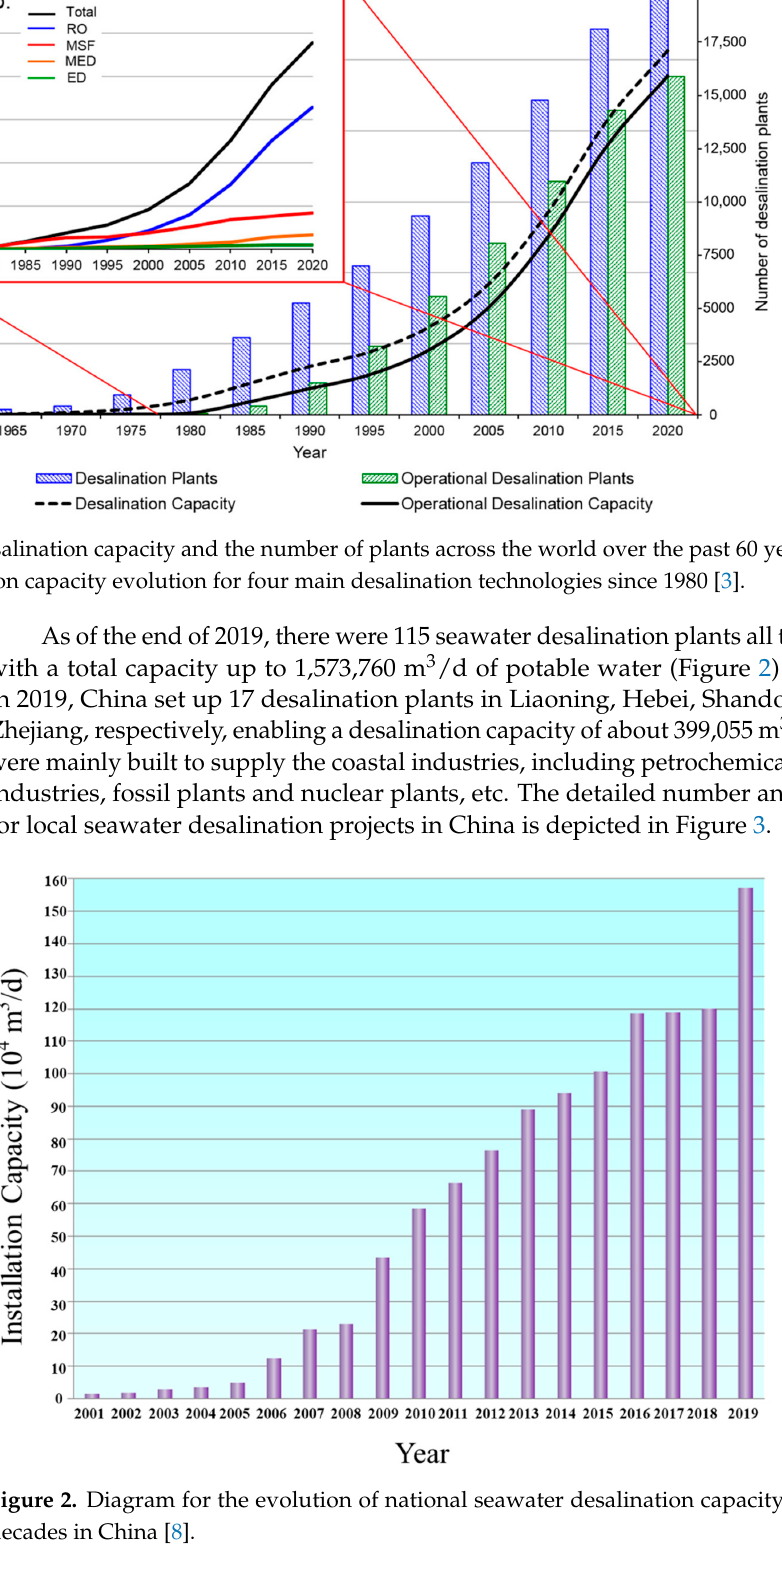
Figure 3. The detailed number and capacity range for local seawater desalination projects in China.